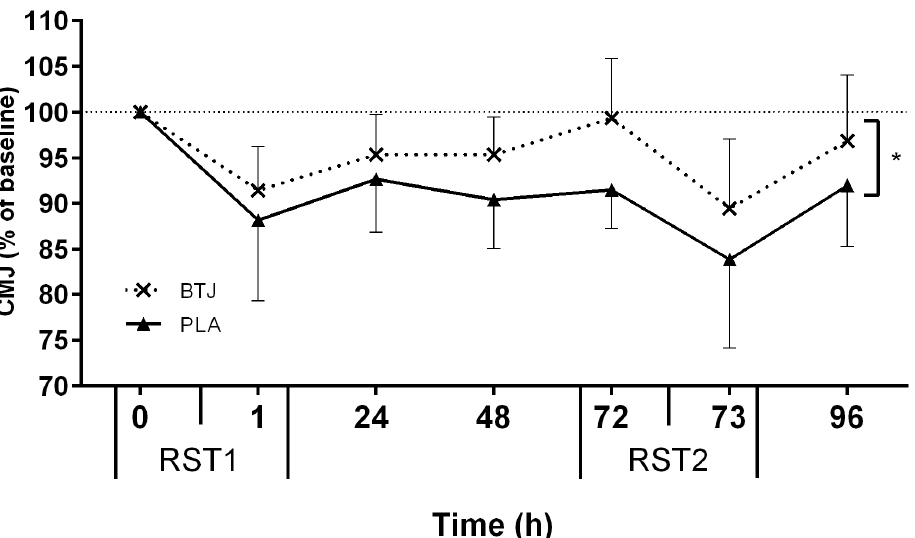
Figure 2. Percentage changes in counter movement jump (CMJ) height between repeated sprint tests (RST1 and RST2). * Represents group difference (beetroot juice (BTJ) vs. placebo (PLA); p < 0.05). Values are mean ± SD ( n = 10 per group).